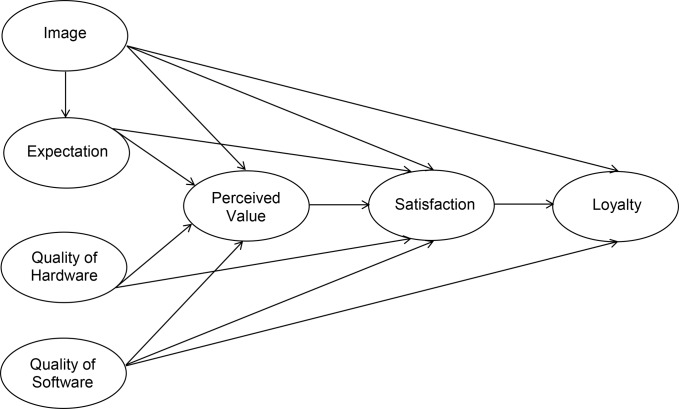
The research model.